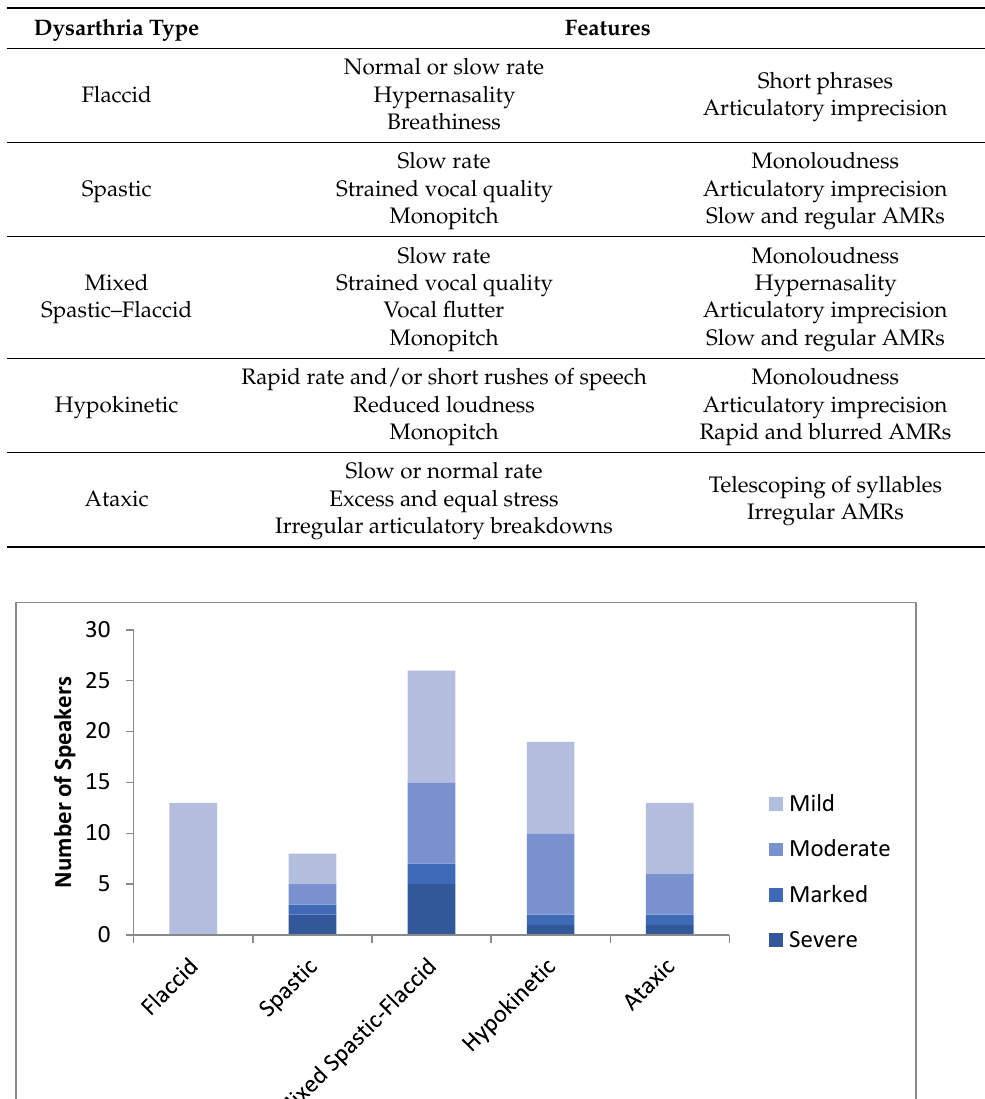
Table 2. Hallmark Features Considered in Differential Diagnosis of Dysarthria [2,30 – 33].